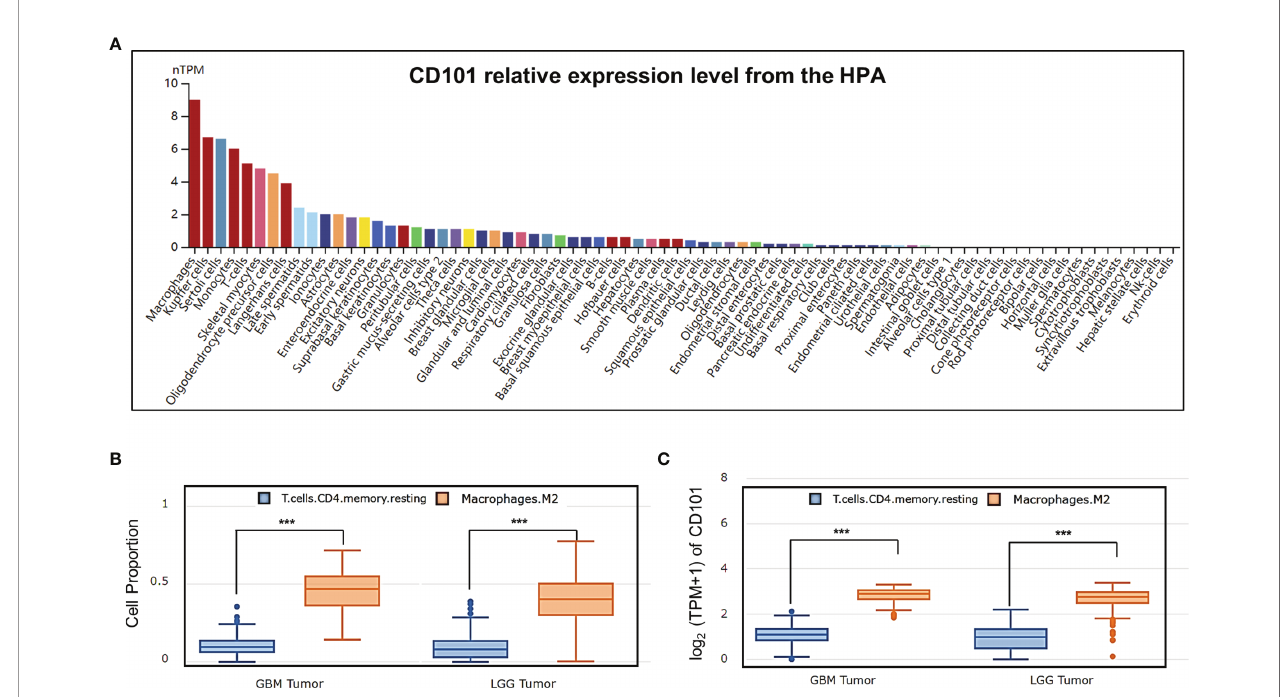
FIGURE 10 | Analysis of CD101 expression based on cell type-level analysis. (A) A summary of single-cell RNA normalized expression from all single-cell types in the HPA. (B) Cell proportion analysis between M2 and T cell CD4+ memory resting in glioma based on the GEPIA2021 database. (C) CD101 expression level analysis between M2 and T cell CD4+ memory resting in glioma based on the GEPIA2021 database (*** p <